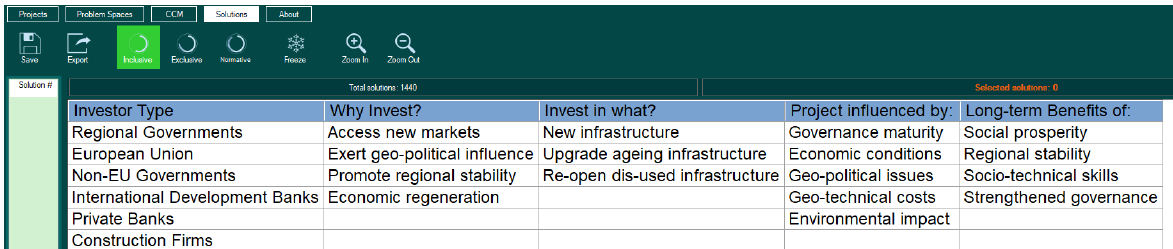
Figure 2: Initial morphological field containing six dimensions 1440 possible